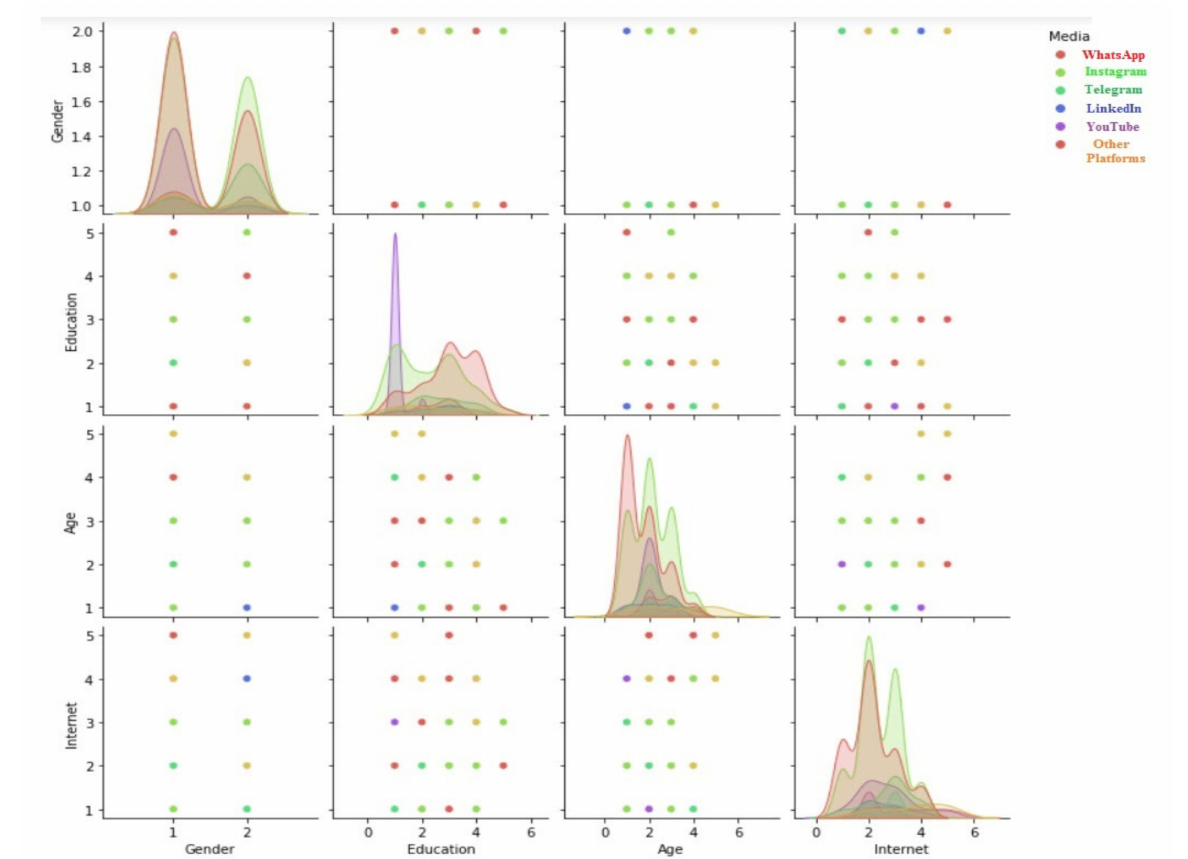
Figure 2. Pair plot of the respondents’ demographic data (Source: authors’ calculations based on Python programming/ Seaborn